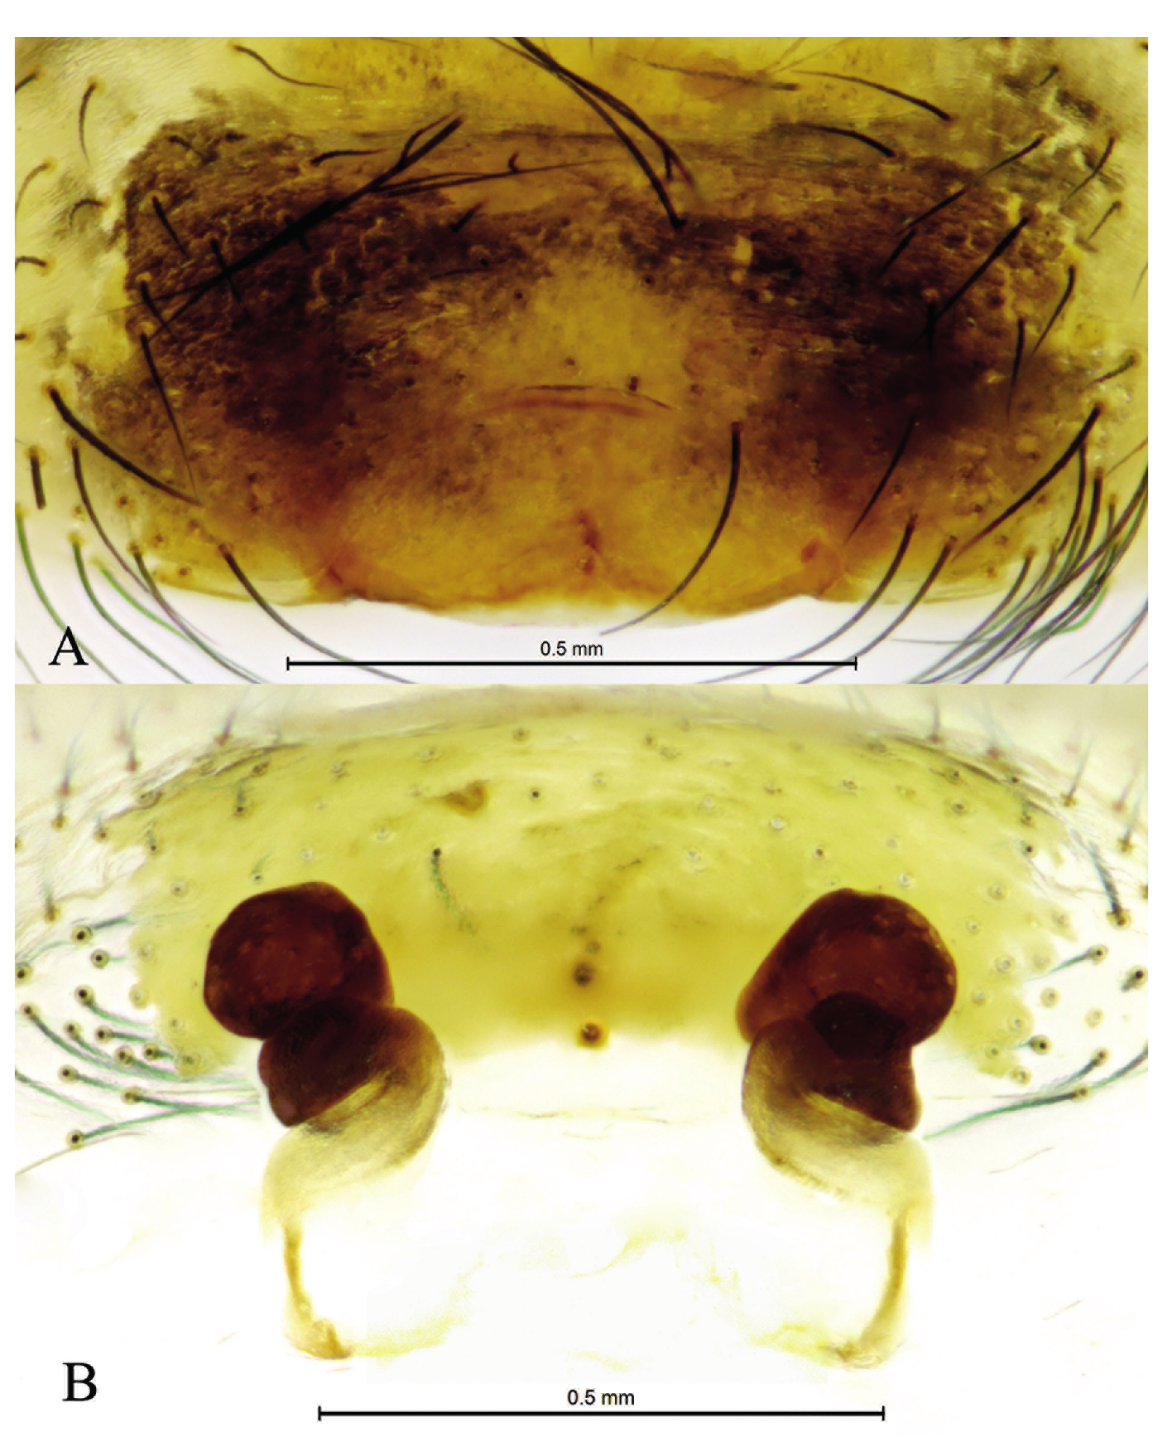
Fig. 15. Meta tibet sp. nov., ♀, paratype (SWUC-T-TEg-06-05). A . Epigyne, ventral view. B . Vulva, dorsal